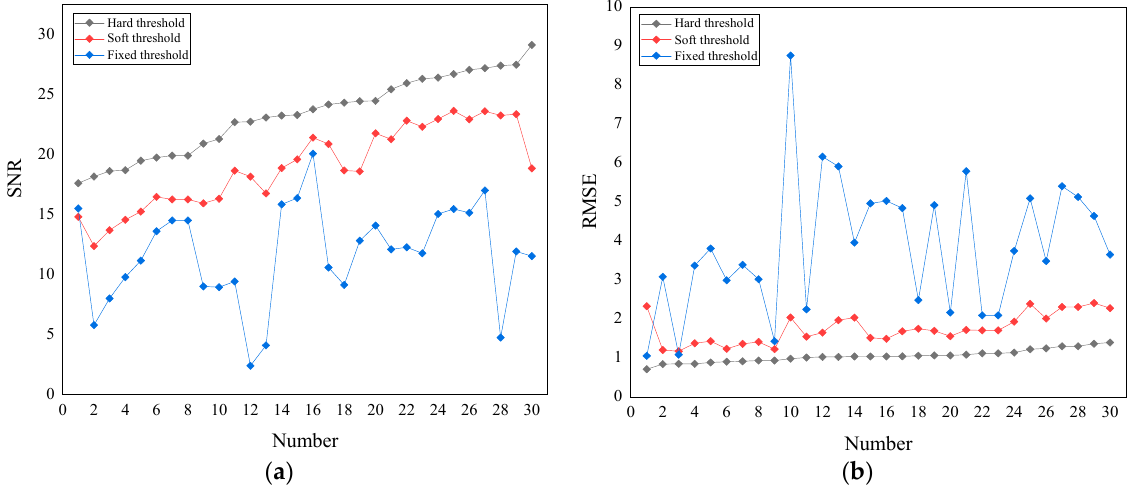
Figure 7. Evaluating indicator performance comparisons with different noise reduction methods: ( a ) SNR, ( b ) RMSE.